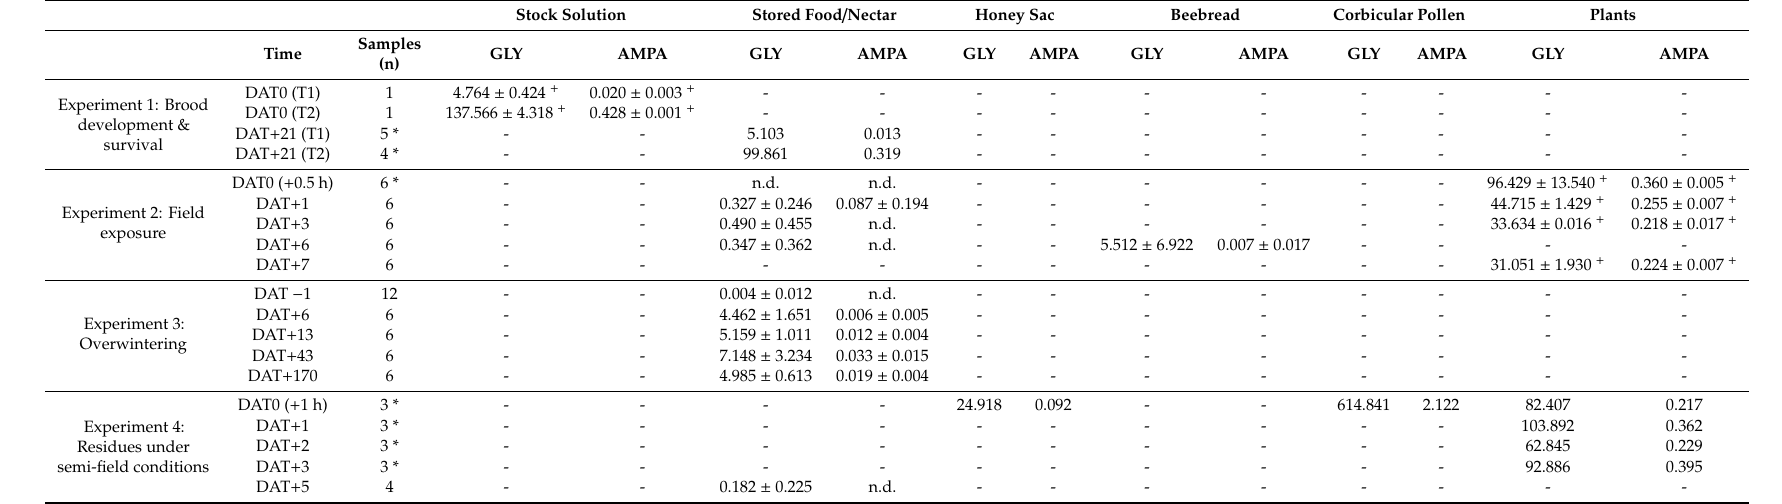
Table 1. Glyphosate (GLY) and aminomethylphosphonic acid (AMPA) residues corresponding to the assessment date (DAT = day after treatment) and matrix from all four experiments (T groups only). For the detection limits of the method, see the materials and methods section. All values are rounded and presented as means ( ± SD) in mg a.i. / kg where appropriate (for details of the method, repeat determination, and trace residues found in controls, see Supplementary Materials Method S2 and raw data [46]. *: pooled sample, + : analyzed twice, n.d.: not detectable, -: not measured). Stock Solution